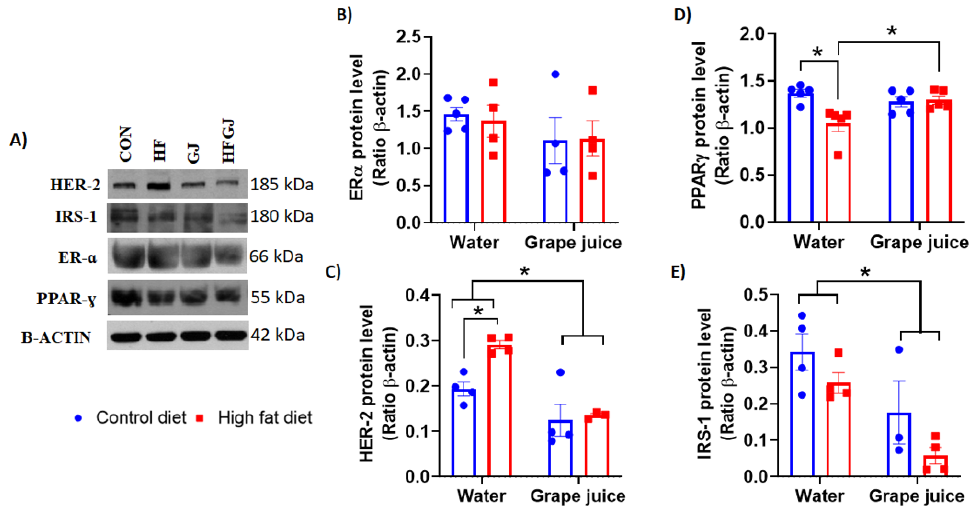
Figure 6. ( A ) Representative Western blots and quantitated data of (B) ERα, (C) HER2, (D) PPAR- Ɣ and (E) IRS-1 protein levels in the mammary glands of 7-week-old female offspring from the control or HFD fed dams which either drank tap water or grape juice. The data are expressed as the mean ± SEM. * Statistically significant difference ( p ≤ 0.05); ** p < 0.01 according to two-way ANOVA followed by Sidak’s test. IRS-1 * p < 0.05 for water vs. grape juice.